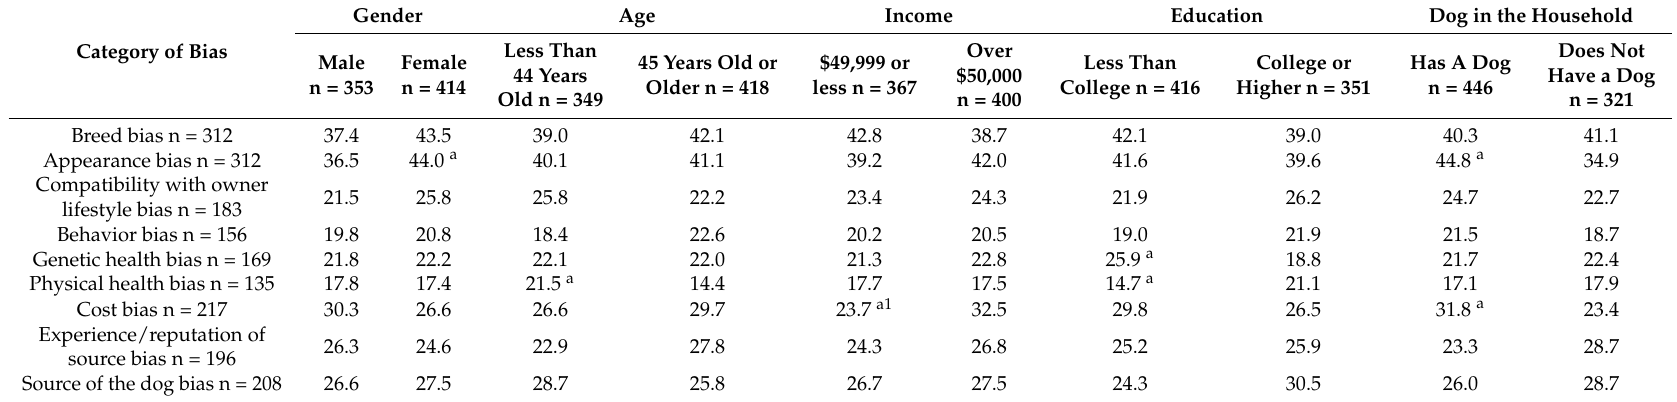
Table 8. Cross tabulations of the presence of social desirability bias in choices relating to a specific dog characterization and respondent demographics. Percentage of respondents calculated as the percentage of each demographic category that exhibited social desirability bias (n =